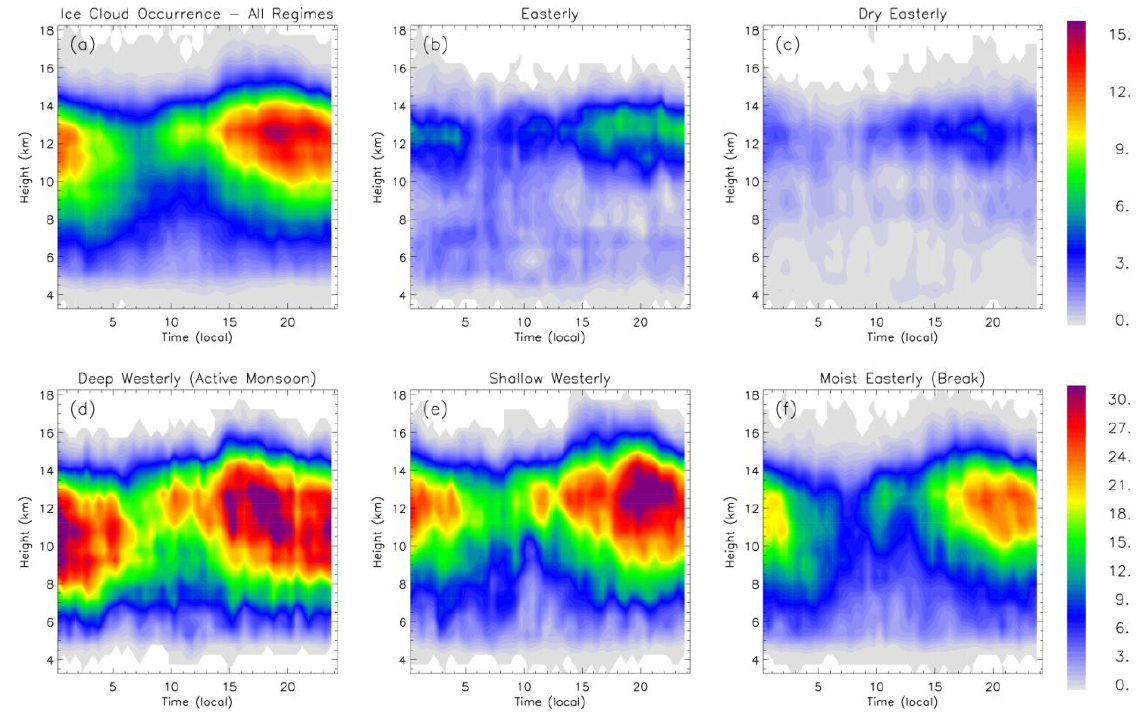
Figure 2: Time-height cross-section of the frequency of ice cloud occurrence (in %) over the Darwin site with all regimes included (a), and for the following large-scale atmospheric regimes: Easterly (b), Dry Easterly (c), Active Monsoon (d), Shallow Westerly (e), and Moist Easterly (f).